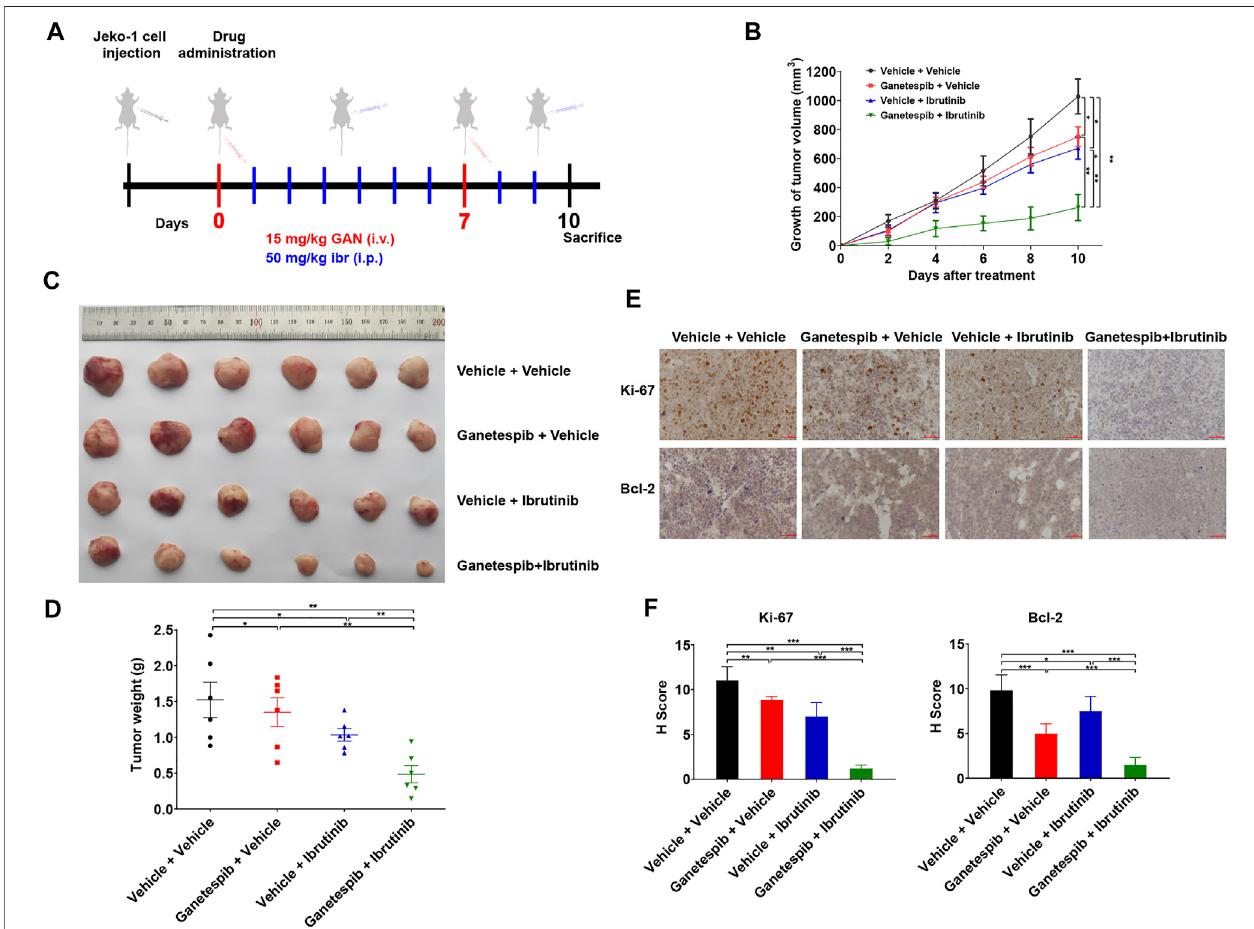
FIGURE 4 | Ganetespib increased inhibition of tumor growth mediated by ibrutinib in the mouse model. (A) . The scheme of in vivo experimental settings. Mice bearing Jeko-1 xenografts ( n = 6/group) were randomly grouped into four groups and treated with 15 mg/kg ganetespib (or vehicle) once weekly by i.v. and 50 mg/kg ibrutinib (orvehicle)daily by i.p.over aperiod of10 days. (B) .Ganetespib signi fi cantly increased inhibition oftumor growth mediated by ibrutinib. Datashow the average growth of tumor volumes calculated at the indicated days and the error bars are the S.D. (C) . The picture of the tumors at the day of sacri fi ce. (D) . Ganetespib signi fi cantly increased inhibition of tumor growth mediated by ibrutinib. Data show the average tumor weight and the error bars are the S.D. ( n = 6/group). Differences among groups were compared by the Mann – Whitney test, with p < 0.05 considered signi fi cant (* p < 0.05; ** p < 0.01). (E,F) Representative images of IHC staining and statistics of the expression of Ki-67 and BCL-2 in the tumors after treatment (scale bar = 50 μ m). Mean ± SD, n = 3.